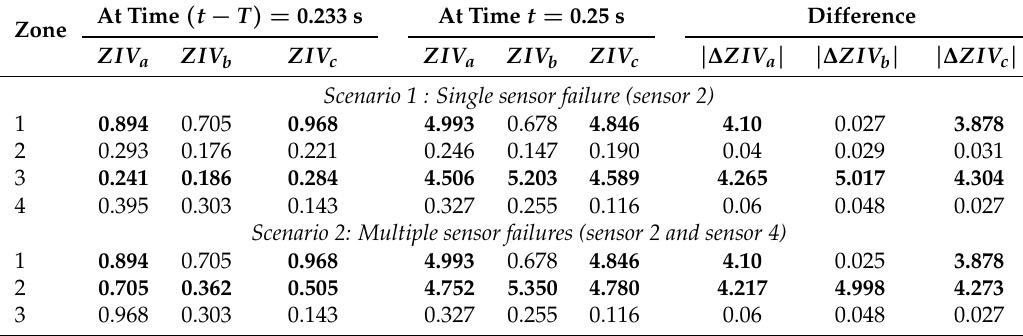
Table 4. | ∆ ZIV | vectors for phase a,b,c for test case 3 for fault detection under device failures. (The value shown in bold indicate fault on respective phases. All the values shown are calculated in p.u).